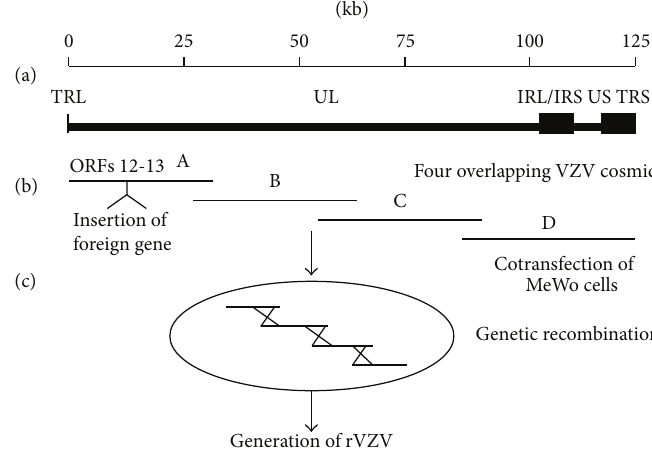
Figure 1: Cosmid approach to generate rVZV. (a) The 125 kb VZV genome consists of a unique long (UL) component flanked by internal and terminal inverted repeat sequences (IRL and TRL) covalently linked to a unique short (US) component bracketed by internal and terminal inverted repeats (IRS and TRS) [17]. (b) Four cosmids (30–45 kb), representing the entire VZV genome, are transfected into MeWo cells yields infectious virus. In this example, a foreign gene with a promoter is inserted into cosmid A, within the intergenic region between VZV ORFs 12 and 13.